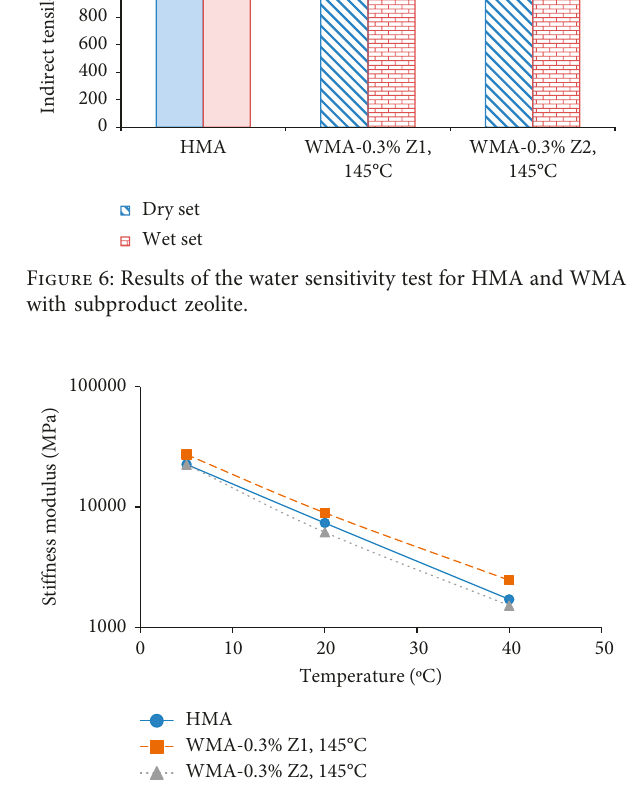
Figure 7: Stiffness modulus at different temperatures for both HMA and WMA with zeolites.